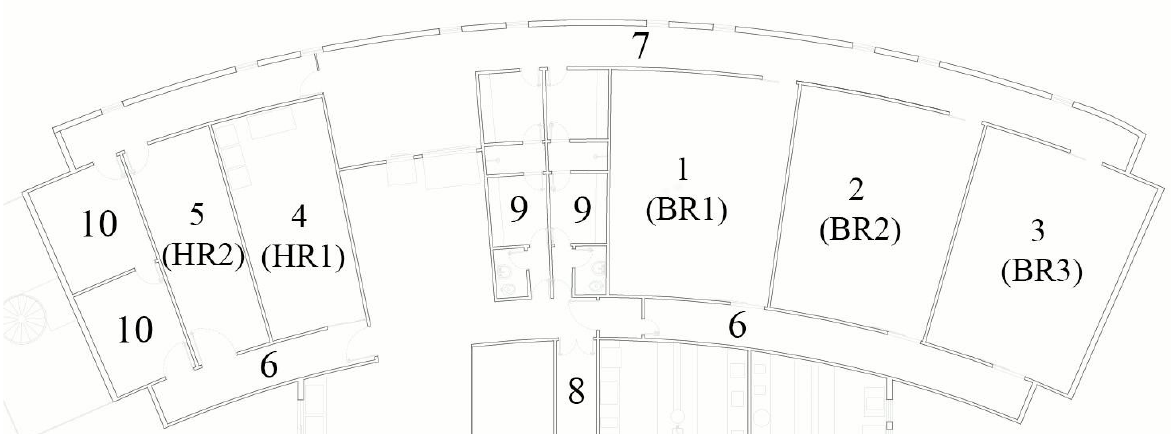
Figure 1. Rodent facility floor plan. 1. breeding room 1; 2. breeding room 2; 3. breeding room 3; 4. housing room 1; 5. housing room 2; 6. clean corridors; 7. dirty corridors; 8. area entrance; 9. restrooms and staff locker room; 10. storage